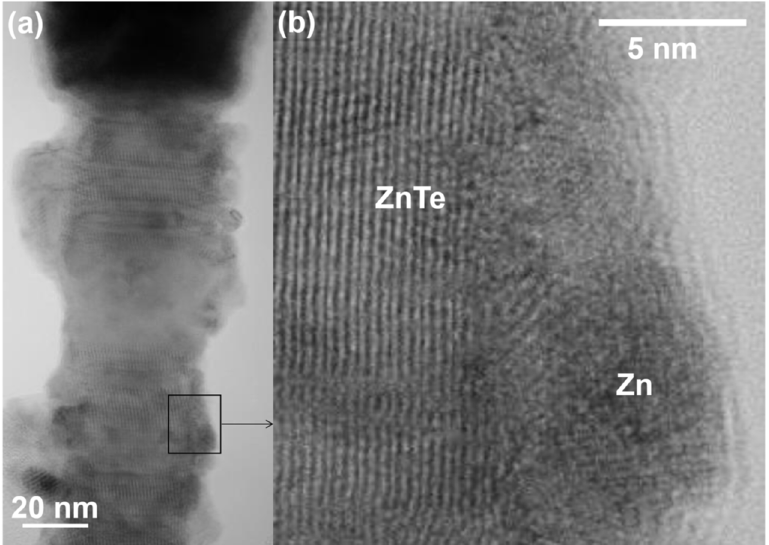
Figure 2. Transmission electron microscopy images of ( a ) part of as-grown Zn-covered ZnTe NW; ( b ) the blown-up section indicated in panel ( a ). This panel indicates a high crystallographic quality of ZnTe NW’s core and a polycrystalline Zn shell.